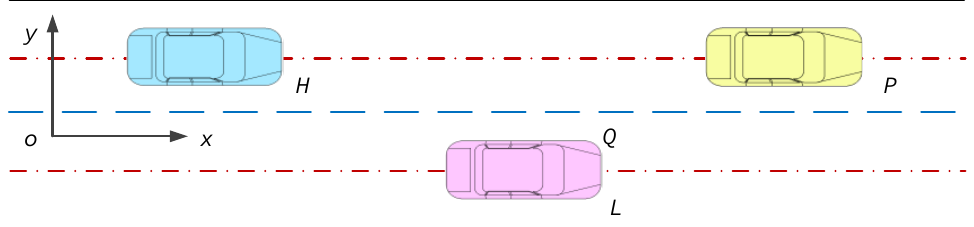
Figure 13. Straight lane cut-in scenario.